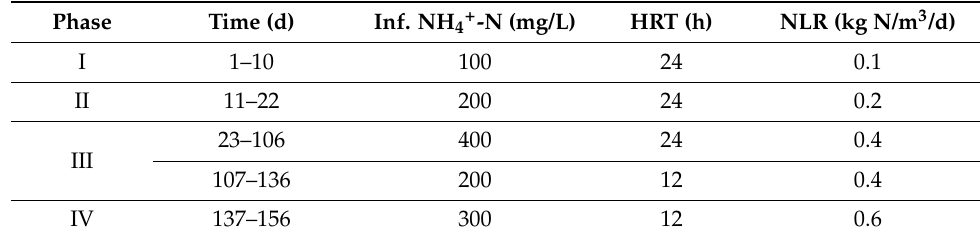
Figure 1. The schematic diagram of the ceramic membrane system. Table 1. Operation parameters of four different stages.